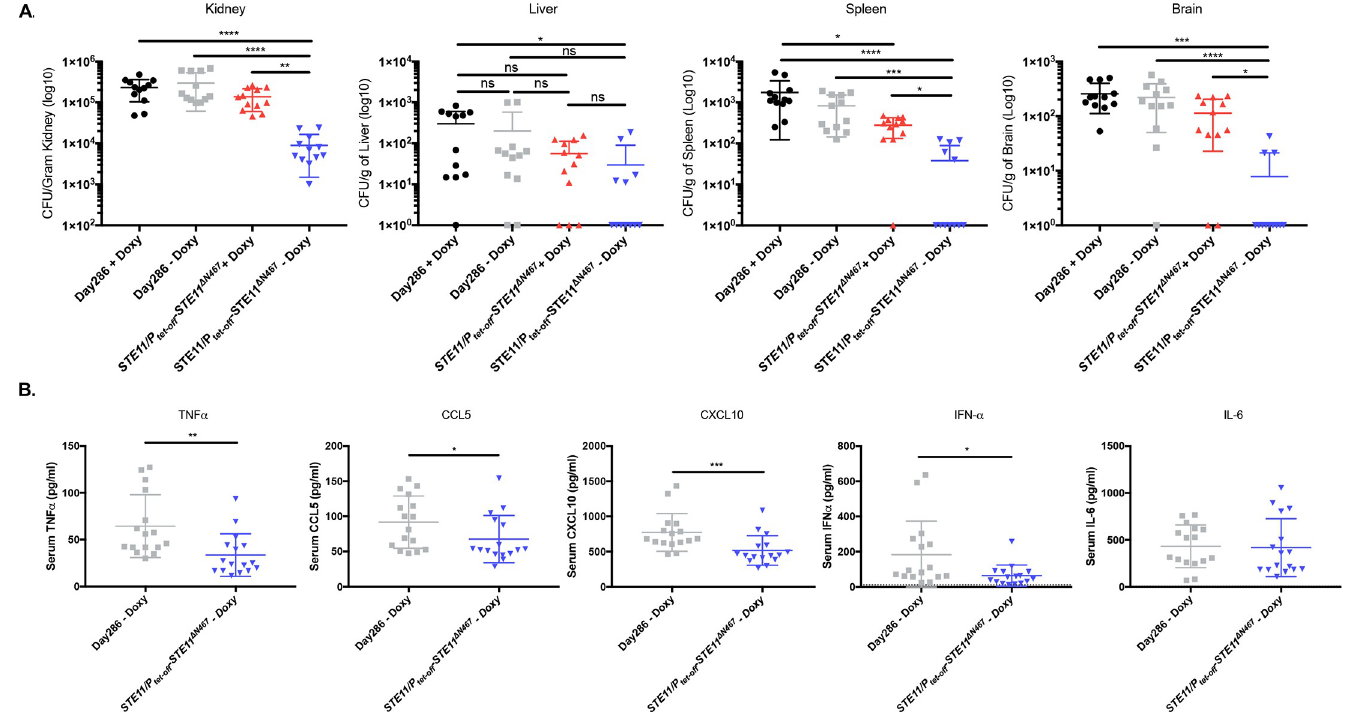
Fig 1. Systemic infection with a hyperactive STE11 Δ N467 mutant attenuates fungal burden in multiple niches within a mouse host. (A) ICR mice were Δ N467 strain and their kidneys, livers, spleens, and brains were intravenously infected with 1x10 6 cells of C . albicans wild-type (Day286) or the STE11/P tet-off -STE11 harvested 4 days post infection (d.p.i.) to assess fungal burden. (n = 6 mice)( � p < 0.05, �� p < 0.01, ��� p < 0.0005, ���� p < 0.0001, by Kruskal-Wallis test with Dunn’s multiple comparisons post-hoc analysis). (B) Serum collected 4 days post infection was assessed to determine the protein concentrations of TNF α , CCL5, CXCL10, IFN α and IL-6 via flow cytometry using the LEGENDplex cytokine bead-based array kit. (n = 8 mice)( � p < 0.05, �� p < 0.005, ��� p < 0.0005, by Mann-Whitney test).